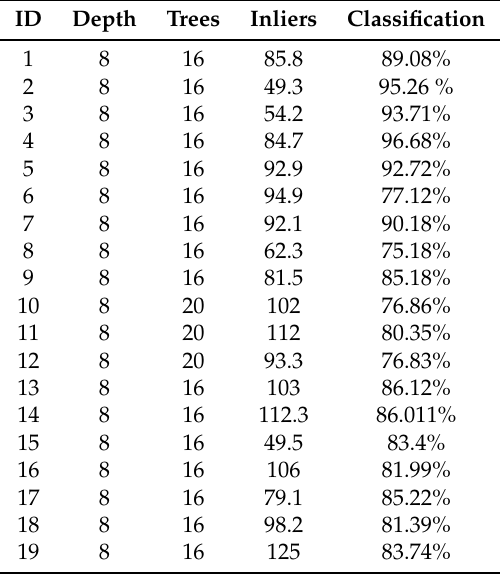
Table 3. Experiment results. ID is the painting identifier, Depth and Trees are the depth of the trees and the number of trees in the forest, Inliers represents the average number of inliers after applying RANSAC and Classification is the average percentage of inliers correctly classified. ID Depth Trees